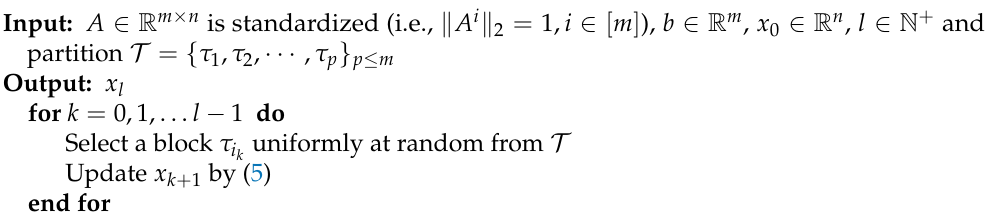
Algorithm 1 The randomized block Kaczmarz method